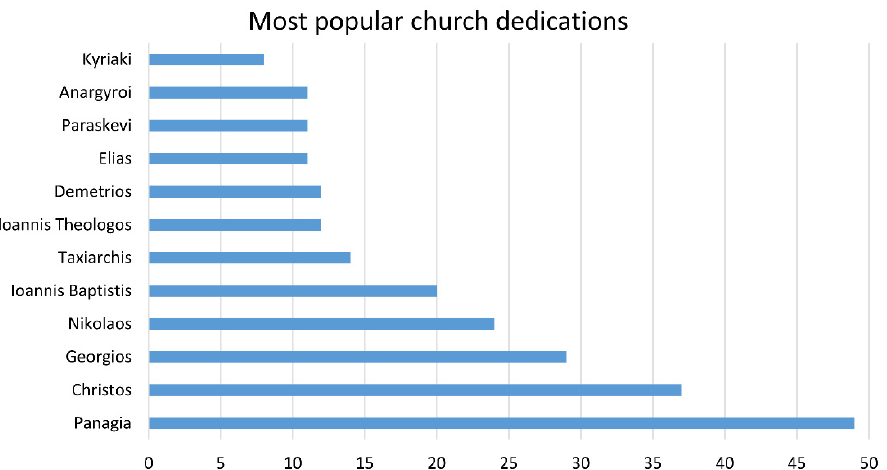
Figure 12. A graph showing the number of churches dedicated to certain saintly figures. The graph includes the names of the saints to whom the dedication occurs in more than five monastic, settlement and outlying churches (data and graph by the author).